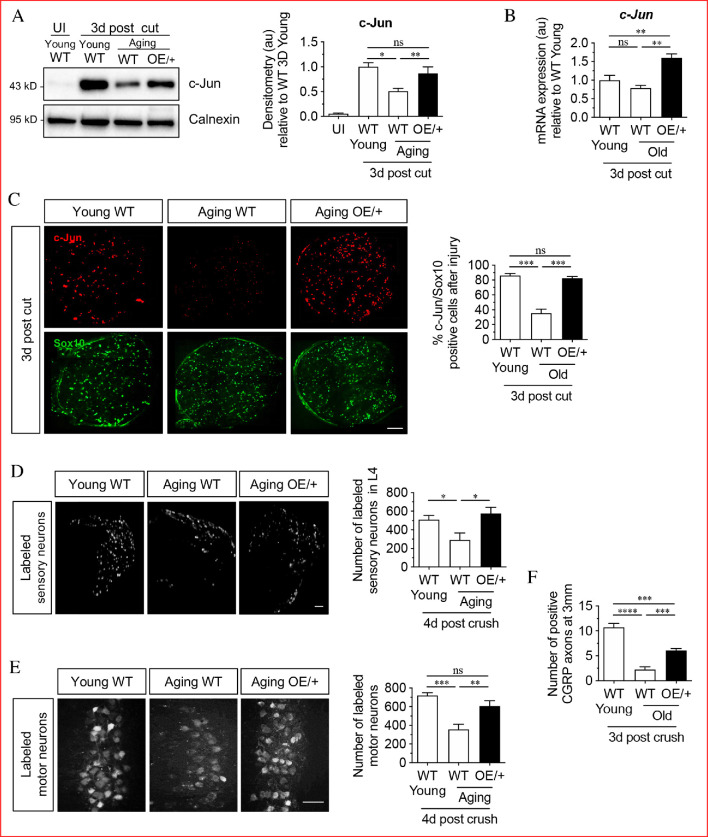
Restoring Schwann cell c-Jun protein reverses the age-related decline in nerve regeneration.(A) Representative western blots of c-Jun in young and aging WT nerves and aging c-Jun OE/+ nerves 3 days post-injury. The graph shows densitometric quantitation of the western blots. c-Jun upregulation is impaired in WT aged nerves but restored in aged c-Jun OE/+ nerves. Data are normalized to young WT 3 days post-cut; *p<0.05, **p<0.005, ns, non-significant. Young UI WT n = 6, n = 5 for all other experimental groups. (B) RTqPCR analysis of 3-day cut nerves. Data normalized to young WT 3 days post-cut.; **p<0.005, ns, non-significant, n = 4. (C) Representative images showing immunofluorescence of c-Jun in double labeling with Schwann cell nuclear marker Sox10 in sections of the distal nerve stump in young and aging WT and aging c-Jun OE/+ mice 3 days post-cut. In the graph, the results are quantitated by cell counting. In aging WT Schwann cells, c-Jun is reduced, but elevated to youthful levels in aging c-Jun OE/+ Schwann cells; **p<0.001, ns, non-significant. n = 3 for each experimental group. (D) Representative images showing Fluorogold-labeled sensory neurons in L4 DRGs of young WT and aging WT and c-Jun OE/+ mice 1-week post back-filling following a 4-day crush injury. The graph shows quantitation by cell counting. There is an age-related decrease in back-filled neurons in WT samples (p=0.0309), while the high number of regenerating neurons in young WT mice is maintained in aging c-Jun OE/+ DRGs (p=0.0211). Unpaired Student's t-test. Young WT n = 6, aging WT n = 5, aging c-Jun OE/+ n = 6. (E) Representative images of Fluorogold-labeled motor neurons in young WT and aging WT and c-Jun OE/+ mice 1-week post back-filling following a 4-day crush injury. The graph shows quantitation of the results. Counts of labeled motor neurons mirrors those of sensory neurons since in WT mice, but not in c-Jun OE/+ mice, the number of back-labeled motor neurons decreases with age; ***p<0.001, **p<0.005, n = 6 for all experimental groups. (F) Counts of calcitonin gene-related peptide (CGRP)+ regenerating axons 3 mm from crush injury of the sciatic nerve of young and aged WT mice, and of aging c-Jun OE/+ mice; ****p<0.0001, ***p<0.001. Young WT n = 5, aging WT and c-Jun OE/+ n = 6. All numerical data are analyzed by one-way ANOVA with Tukey’s multiple comparison test and represented as means ± SEM. All scale bars: 100 μm.